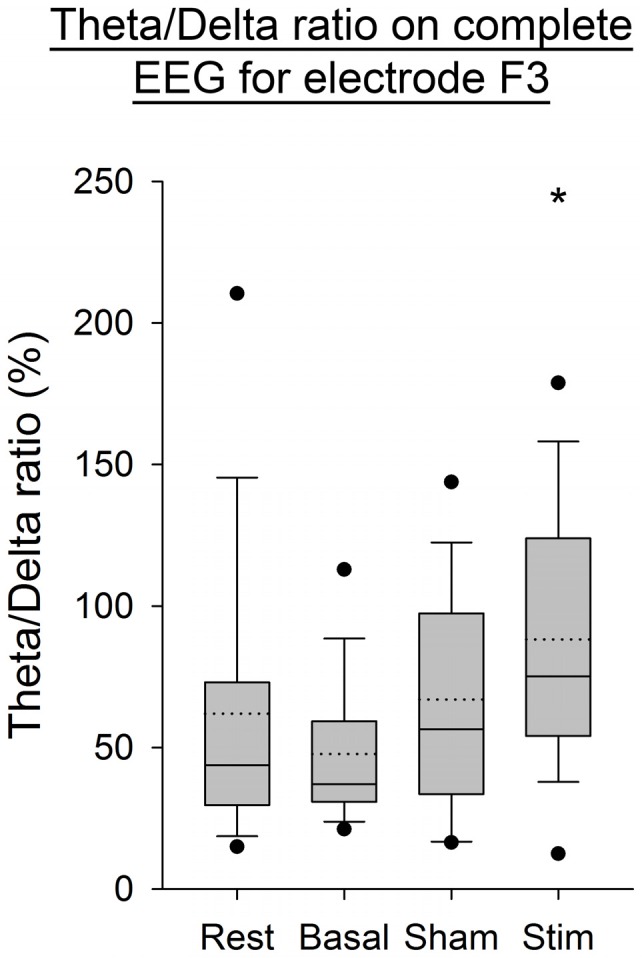
EEG Theta/Delta ratio (complete EEG signal) for the F3 electrode for all subjects per condition. The boxes correspond to the 25–75 percentiles, the continuous lines are the median values, the dotted lines are the mean values and the whiskers represent the 10 and 90 percentiles. The dots are the outlying values. Note the increase for the active stimulation condition. The Theta/Delta ratio is expressed in percent (%), *p < 0.05 as compared to the three other conditions.